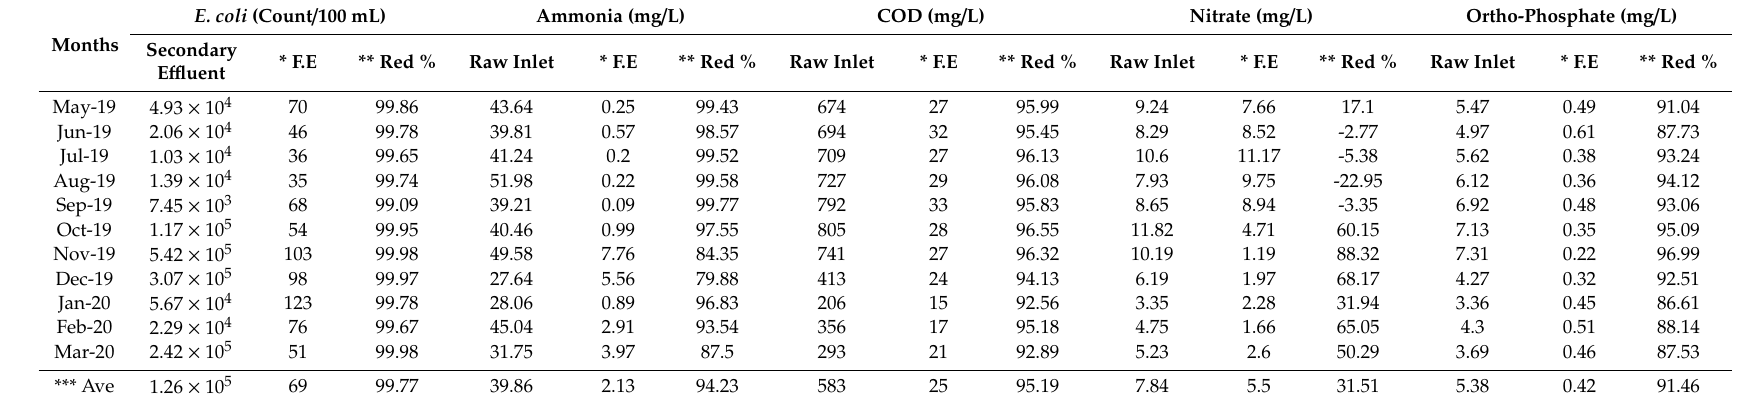
Table 3. Wastewater treatment plant (WWTP) removal e ffi ciency in reducing E. coli , ammonia, COD, nitrate and ortho-phosphate from untreated